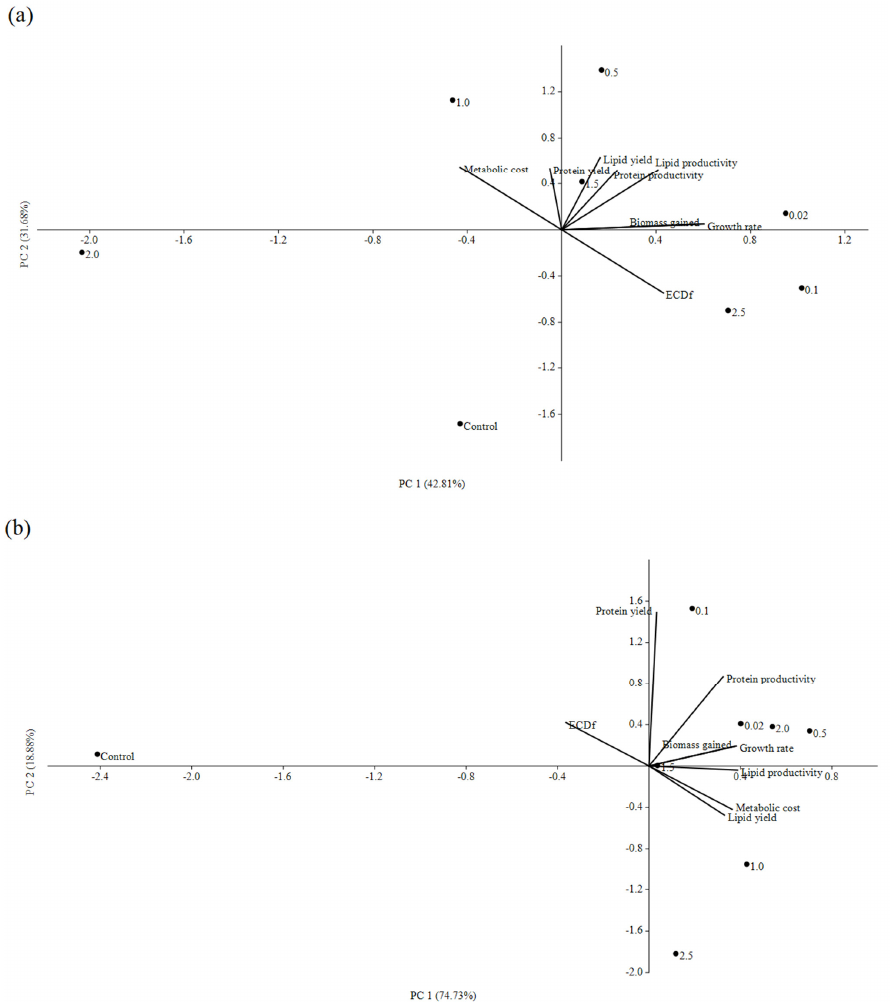
Figure 4. PCA analyses demonstrating the correlations between BSFL growth together with its biochemical products and each in situ ( a ) and ex situ ( b ) fermentation executed by R. oligosporus of various inoculum sizes on CEW.